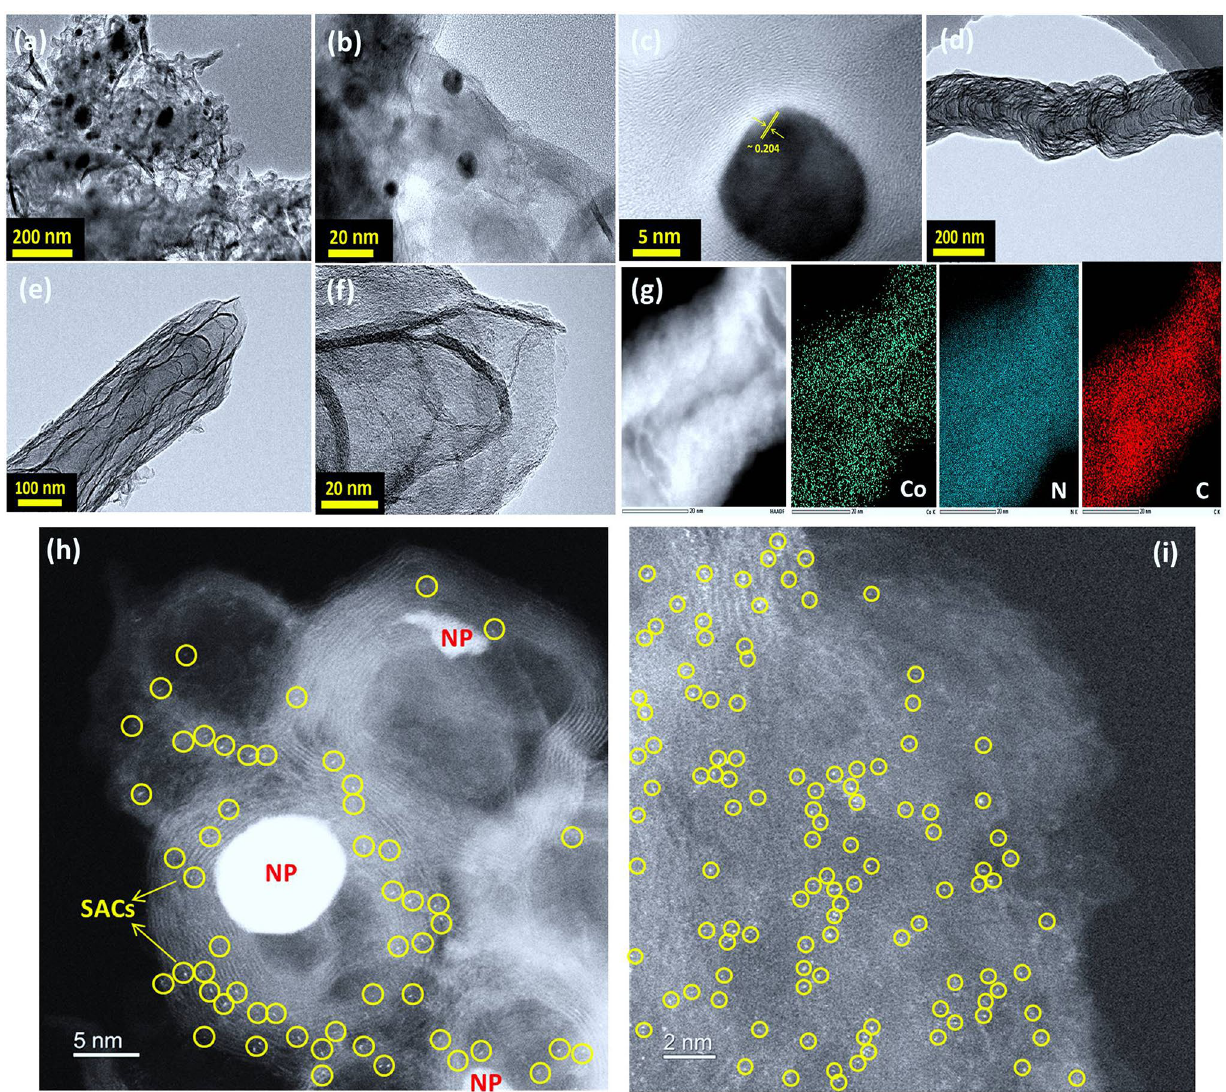
Fig. 2 TEM images of Co@C-CoNC catalyst at different locations and different magnifications: a‑f shows the co-existence of small-sized nano- particles (NPs) and N–C/CNT hybrids of Co@C-CoNC catalyst; g EDS mapping; HAADF-STEM images of: h shows Co SACs adjacent to Co NPs and i represents the isolated Co SACs in a carbonaceous hybrid matrix of Co@C-CoNC